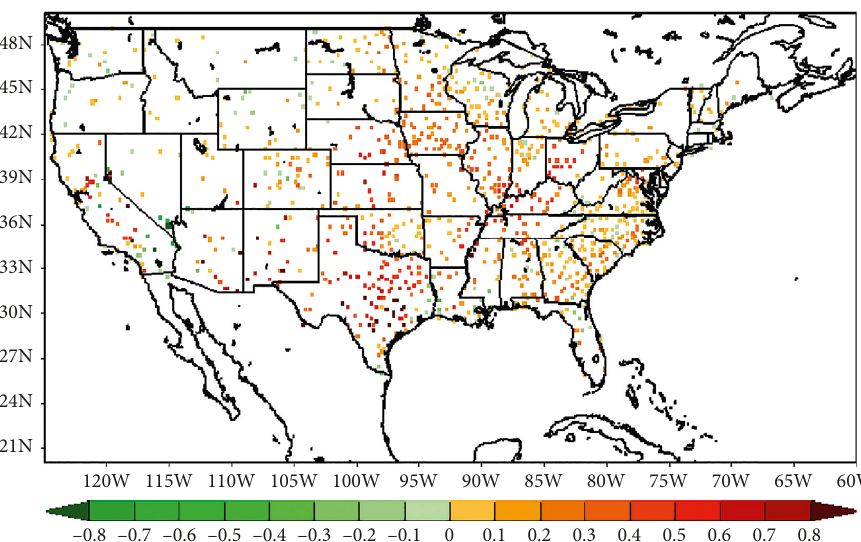
Figure 8: Difference in RMSE of T2m forecasts between WRF run with GVF climatology and one with NRT GVF during the daytime; WRF-clim run minus WRF-NRT run; warm (cool) color means the added (degraded) value.